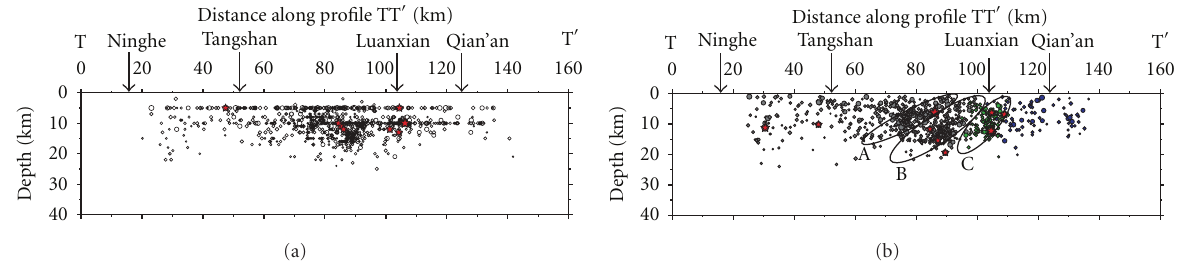
Figure 12: Cross-section along profile TT (cid:5) of focal depth before (a) and after (b) relocation using tomoDD in the Tangshan area. Stars and circles show the earthquakes of M L ≥ 4.0 and M L < 4.0, respectively. The epicentral locations of earthquakes with di ff erent colors in Figure 12(b) are the same as in Figure 11.